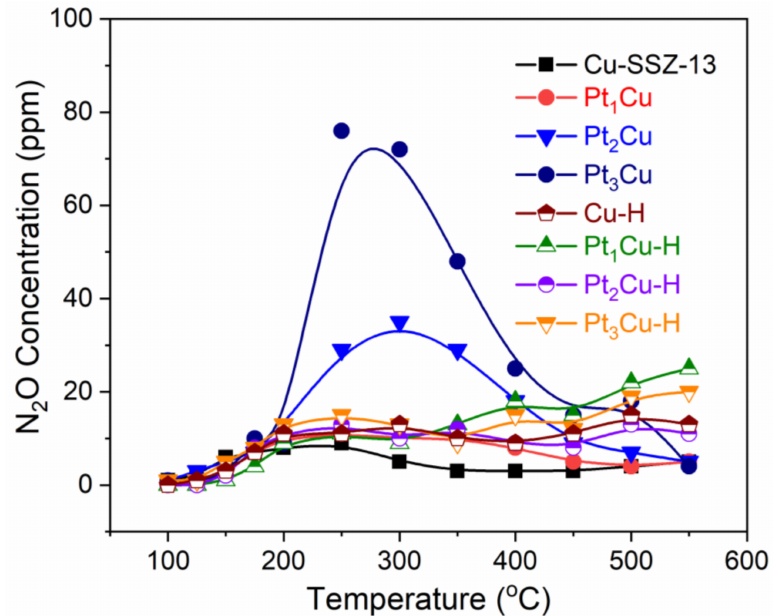
Figure 2. N 2 O concentration during standard NH 3 − SCR of fresh and aged catalyst samples. The re- action conditions: 500 ppm NH 3 , 500 ppm NO, 5% O 2 , 5% H 2 O, N 2 balance, flow rate at 500 mL/min, 100 mg of